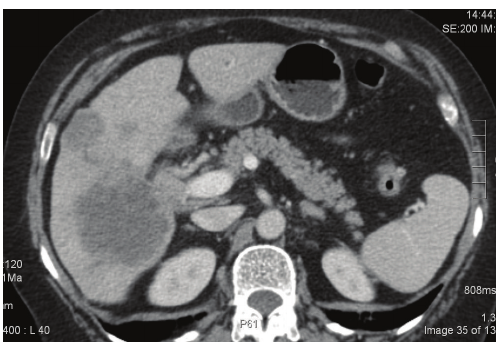
Figure 4: The underlying cholangiocarcinoma with intrahepatic metastasis and hilar extension in patient B.